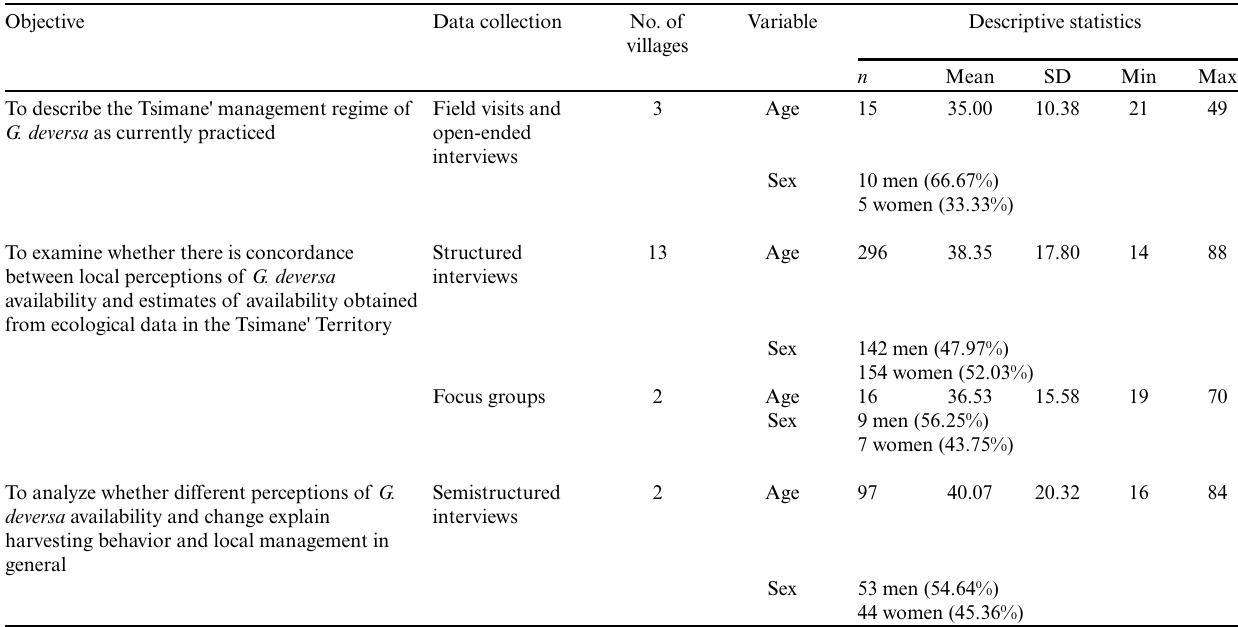
Table 1 . Summary descriptive statistics of the sample